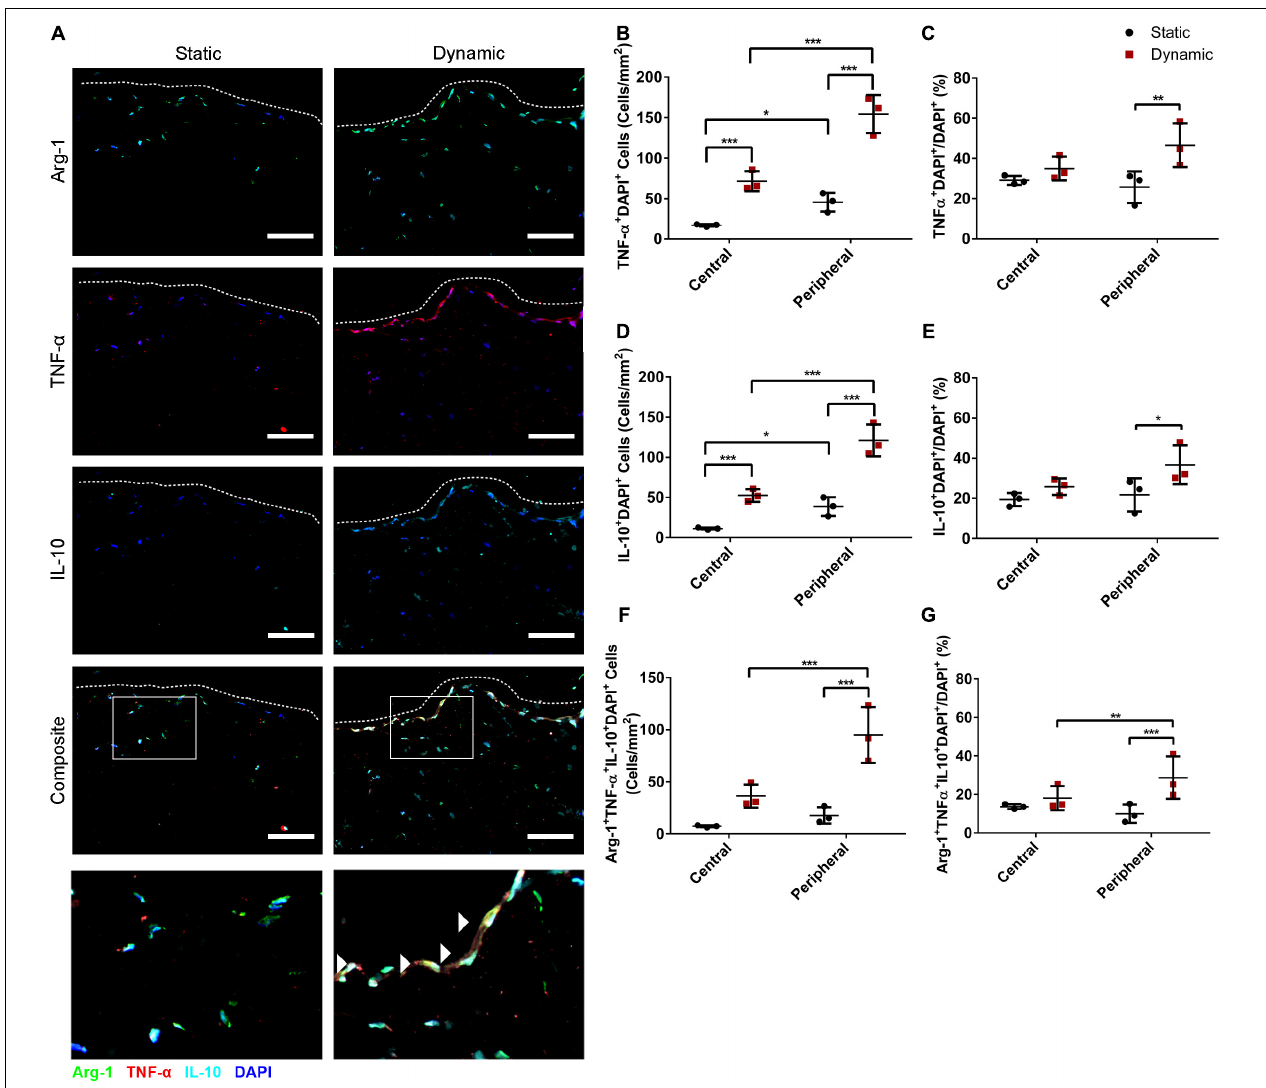
FIGURE 2 | Dynamic culture within the perfusion bioreactor for 14 days increased the percentage of human ASCs expressing TNF- α + and IL-10 + in the peripheral region of the DAT scaffolds. (A) Representative immunostaining showing Arg-1 (green), TNF- α (red), and IL-10 (cyan) expression with DAPI counterstaining (blue) for the static and dynamic groups. Dashed lines indicate the edge of the DAT scaffolds. Scale bars represent 100 µ m. Boxed regions in the composite images are shown at higher magnification below. White arrowheads highlight Arg-1 + TNF- α + IL-10 + DAPI + cells. In the central ( > 200 µ m from scaffold edge) and peripheral ( < 200 µ m from scaffold edge) regions of the DAT scaffolds in the static and dynamic groups: (B) The TNF- α + DAPI + cell density and (C) Percentage of cells expressing TNF- α . (D) The IL-10 + DAPI + cell density and (E) Percentage of cells expressing IL-10. (F) The Arg-1 + TNF- α + IL-10 + DAPI + cell density and (G) Percentage of cells co-expressing Arg-1, TNF- α and IL-10. * p < 0.05, ** p < 0.01, *** p <